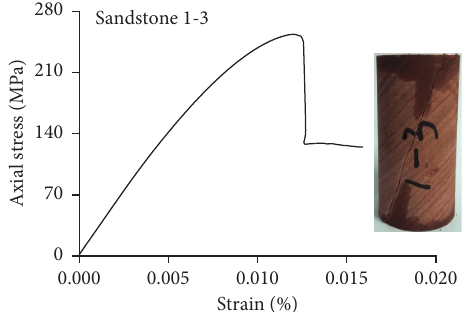
Figure 7: The stress-strain curve of a sandstone [24].